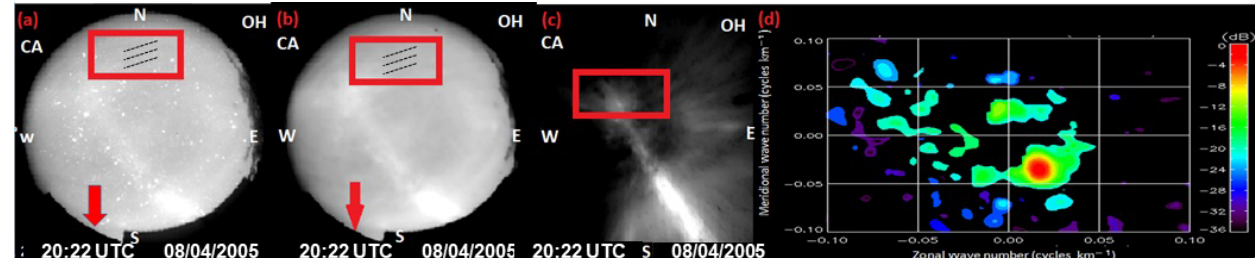
Figure 1. Illustration of the image processing. (a) Raw OH image collected from the ASI in São João do Cariri on 8 April 2005. For more details on the propagation of ripples, see the video clip in the Supplement. (b) The filtered image. (c) The unwarped and rotated image of the GW event inside the red box shown in the previous images for FFT analysis (d) The cross spectrum applied to the GW enclosed in the red box in (c) .